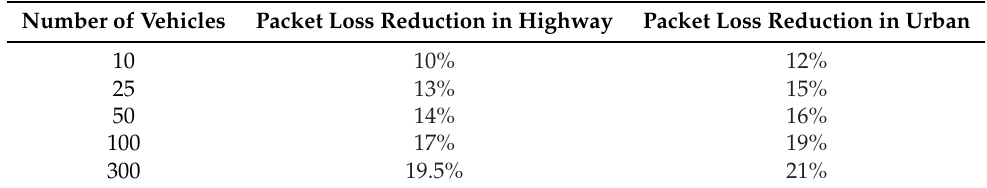
Table 3. Packet loss reduction.